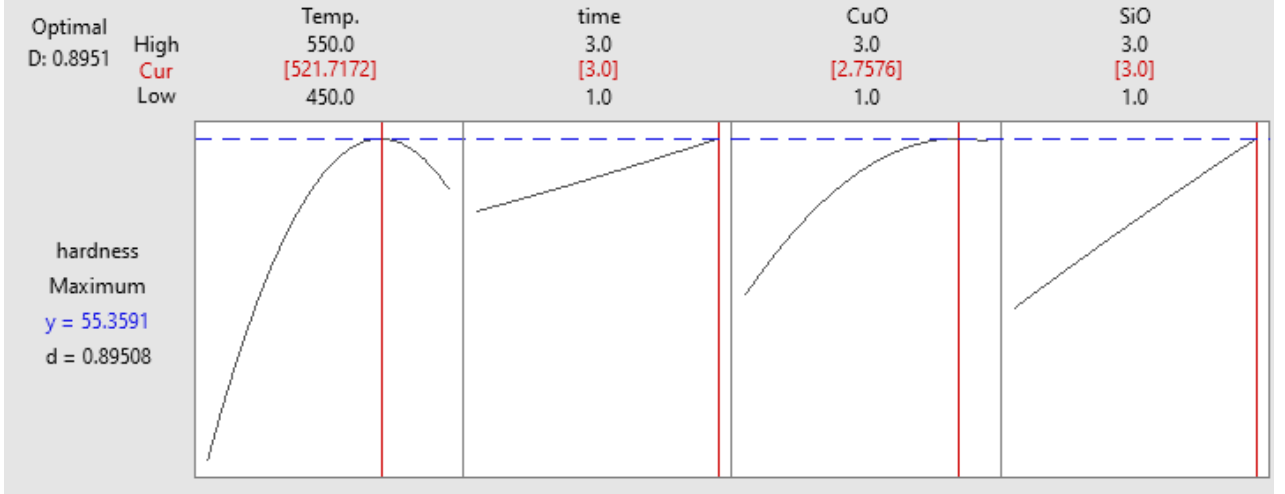
Figure 13. Optimisation plot for microhardness. Table 9. The Density Analysis of Variance by